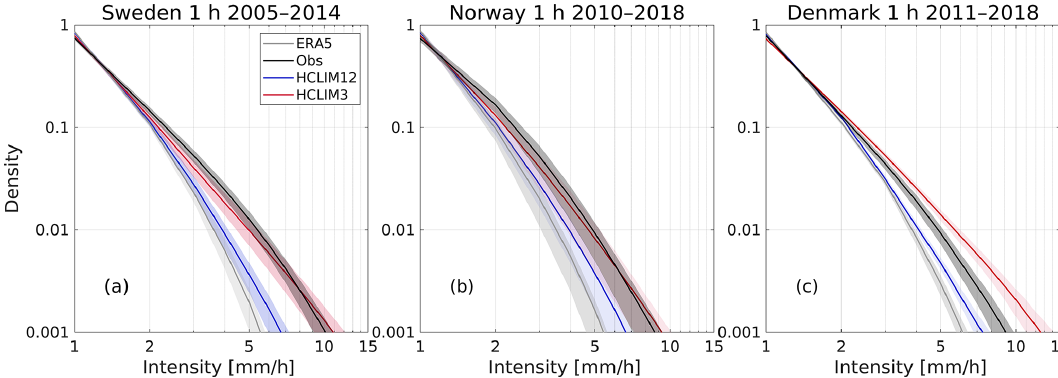
Figure 6. The mean probability density functions of hourly precipitation for (a) Sweden, (b) Norway, and (c) Denmark. The shading presents the 25th and 75th percentiles from the spatial distribution. The label of Obs refers to the national high-resolution gridded datasets. All data are presented on their native grids. A threshold of 0.1mmh − 1 was used prior to analysis.